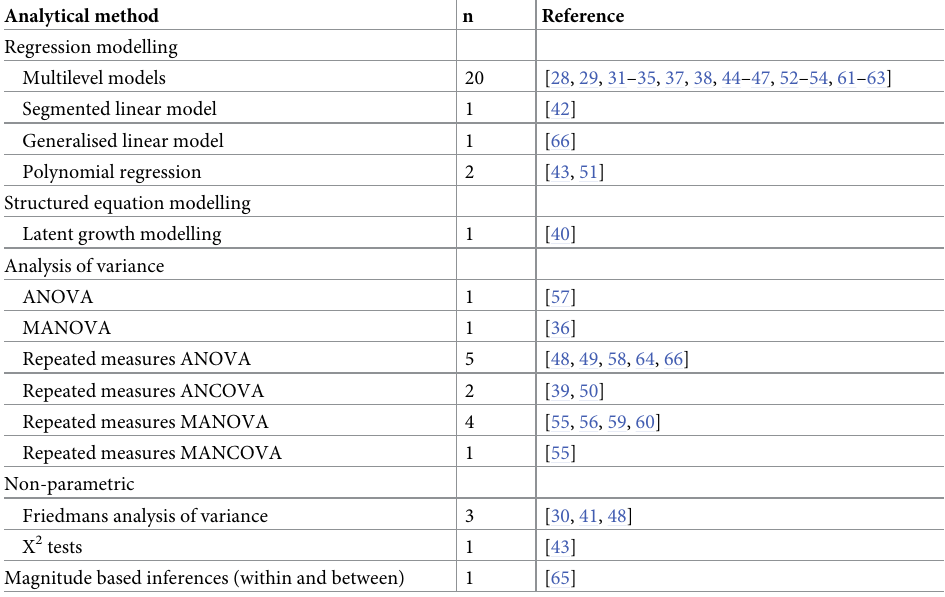
Table 5. The analysis methods used to evaluate the development of physical qualities in the identified